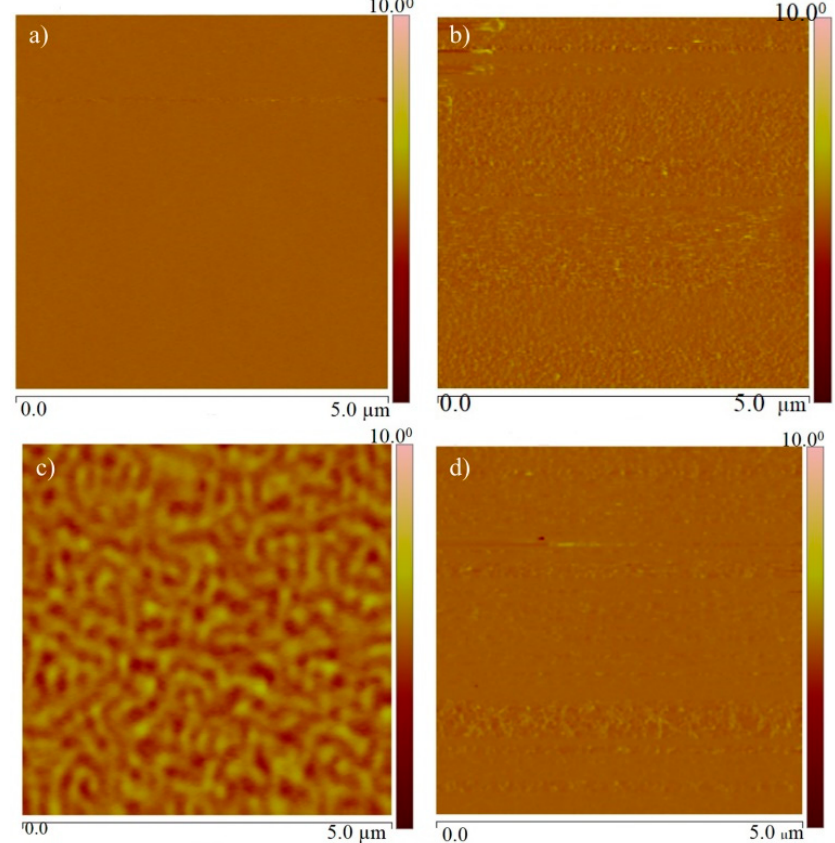
Figure 9. Magnetic force microscopy (MFM) images of ( a ) pure Ni film and films annealed at 400 °C for ( b ) 60 min, ( c ) 90 min, and ( d ) 120 min. Reprinted with permission from [95], Copyright 2019 Elsevier.